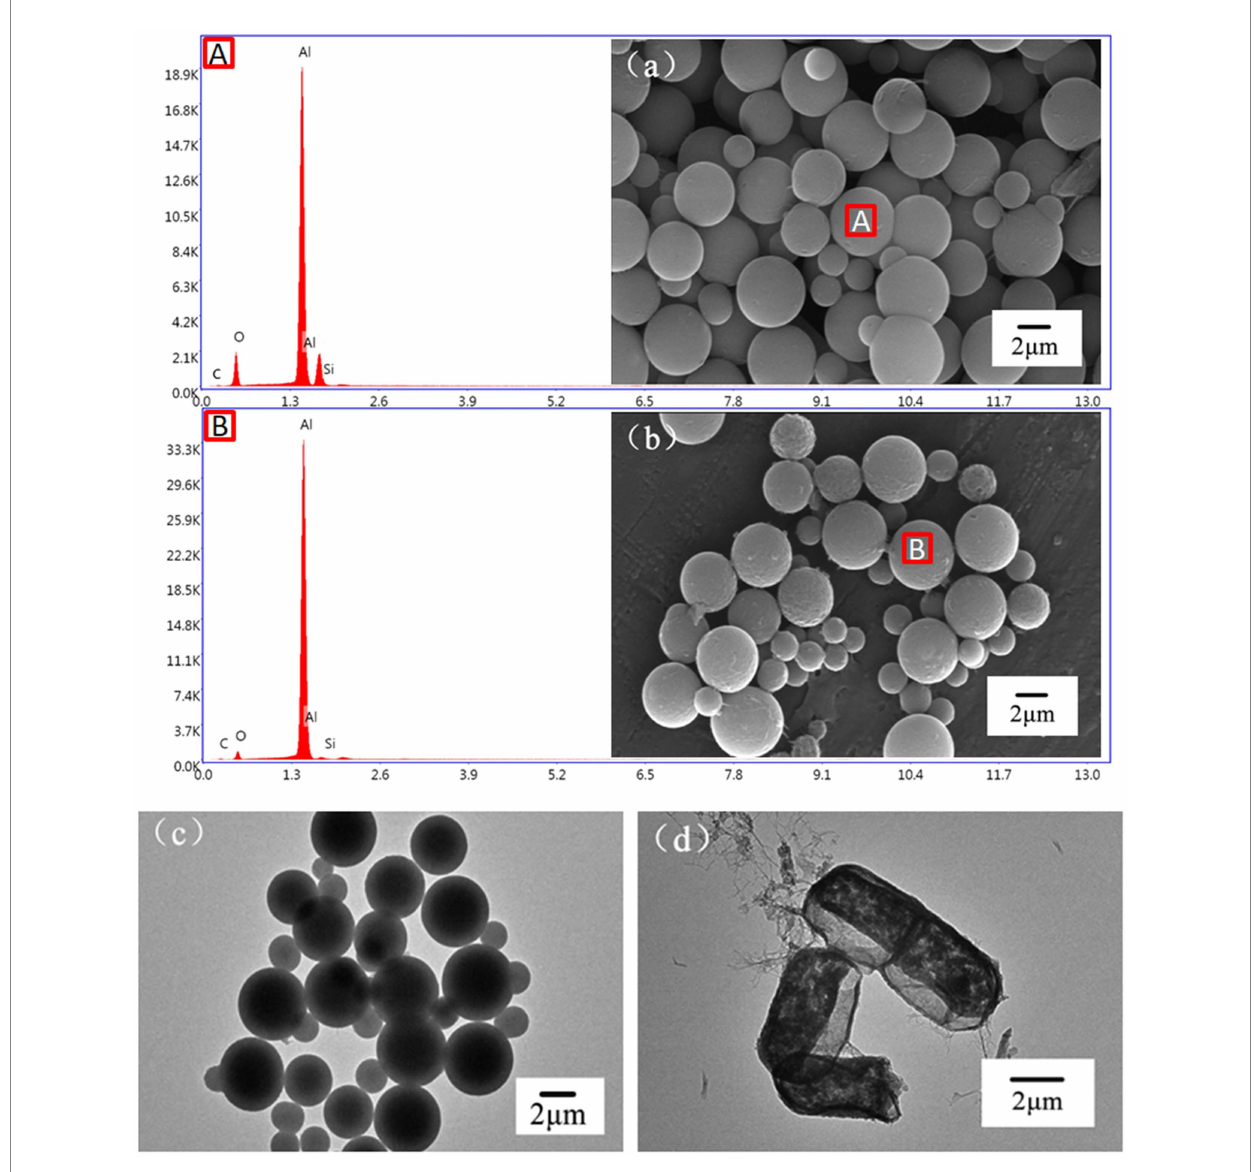
FIGURE 3 SEM and EDS images of LBMs with (A) or without (B) SiO 2 template, TEM images of LBMs with (C) or without (D) SiO 2 template.